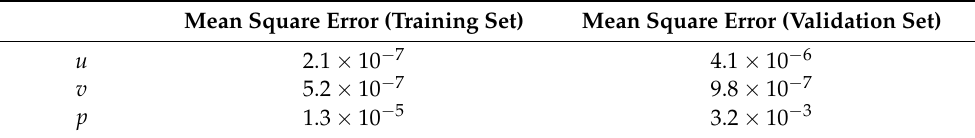
Figure 9. Performance of the Res-PINN for solving the cavity flow. Table 2. The mean square error between predict value and exact value in cavity